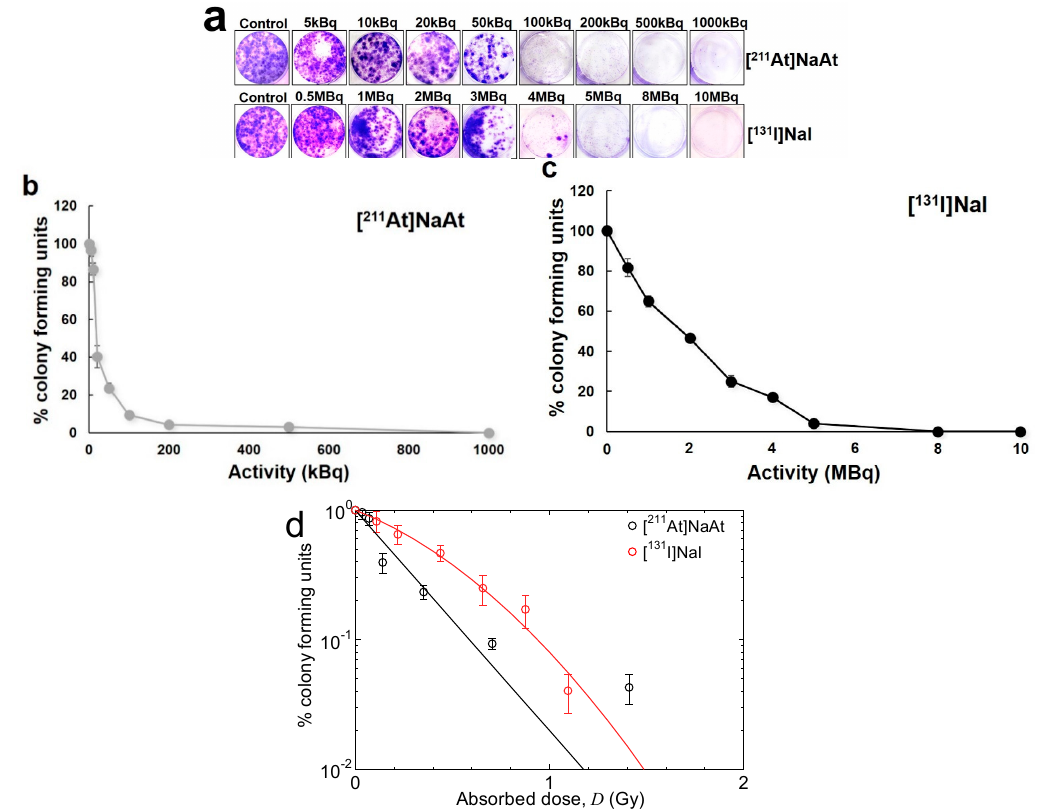
Figure 2. ( a ) K1-NIS cell images stained with crystal violet and ( b , c ) % colony-forming units of K1-NIS cells treated with [ 211 At]NaAt and [ 131 I]NaI solutions. ( d ) Relationship between % colony-forming units and absorbed dose. The results of the linear and linear–quadratic fittings of [ 211 At]NaAt and [ 131 I]NaI data, respectively, are also shown in the figure. For [ 211 At]NaAt, the experimental data for [ 211 At]NaAt with the absorbed doses above 1 Gy were excluded from the fitting, because they were probably influenced by the heterogeneity of the radioactive concentration in each cell.